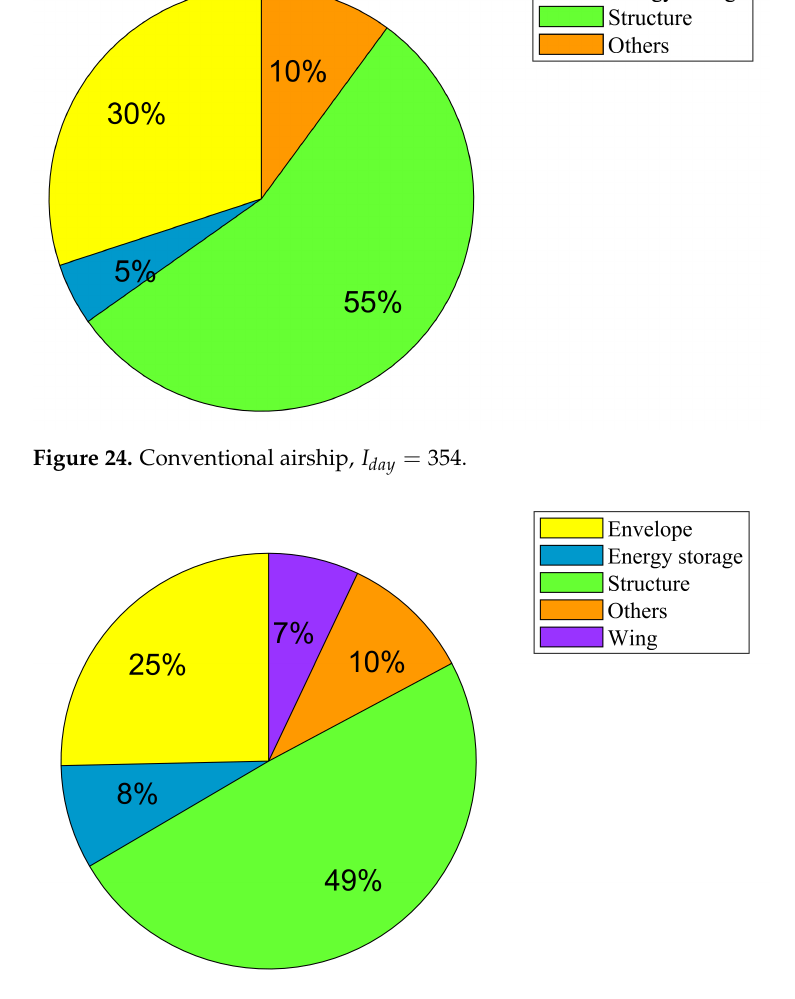
Figure 25. Winged hybrid airship, I day =